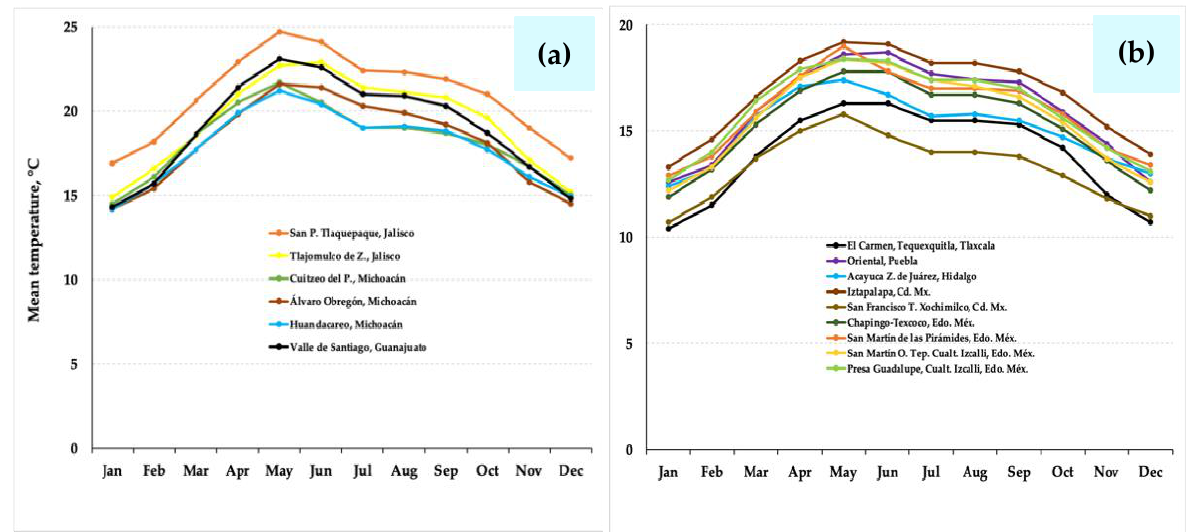
Figure 3. Historical precipitation data from nine stations in NW Mexico (Baja California Sur and Sonora) and the SW region of the USA (California), where several species of Suaeda are reported.